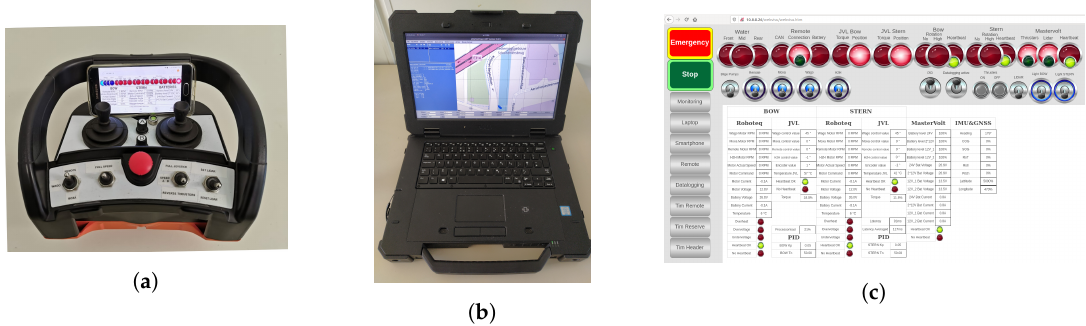
Figure 5. The previous line-of-sight shore side control components (summer 2019): ( a ) wearable remote controller with web-interface, ( b ) the rugged computer (R-PC) running MOOS-IvP, and ( c ) an additional laptop monitoring the PLC